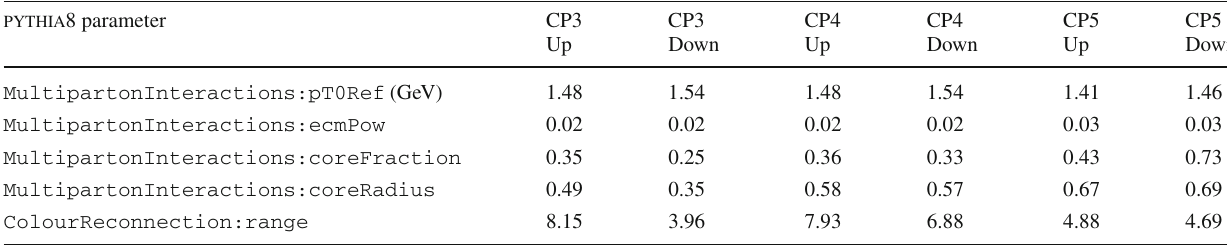
Table 7 Parameters of the “up-” and “down-” variation eigentunes for the pythia 8 CP3, CP4, and CP5 tunes pythia 8